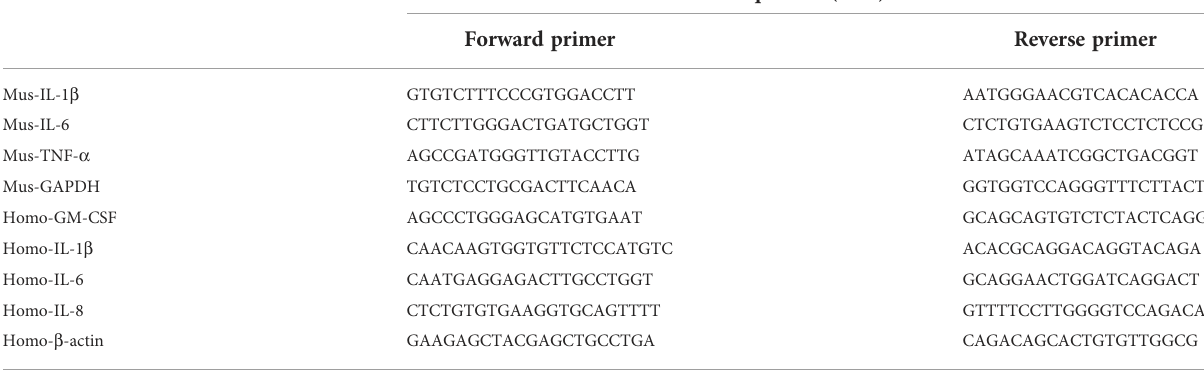
TABLE 1 The primer Sequences of